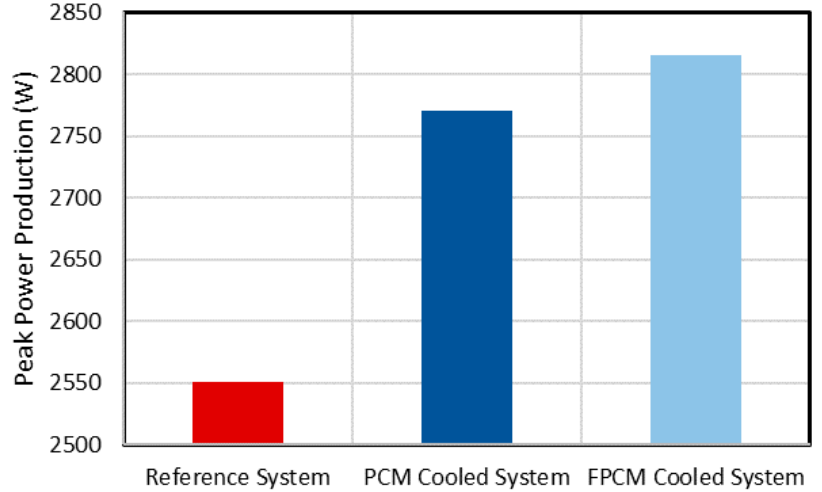
Figure 5. Power production by reference system, PCM cooled system and FPCM cooled system.